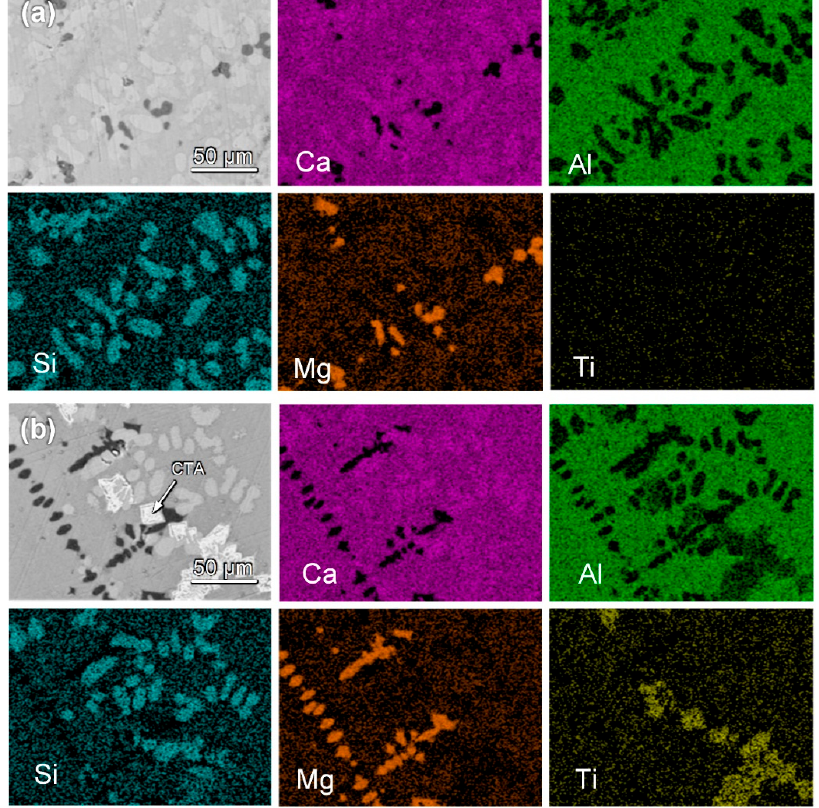
Figure 11. Elemental mappings of slag with different TiO 2 contents (1310 ◦ C, R = 6): ( a ) Slag A1, w (TiO 2 ) = 0%; ( b ) Slag A3, w (TiO 2 ) =